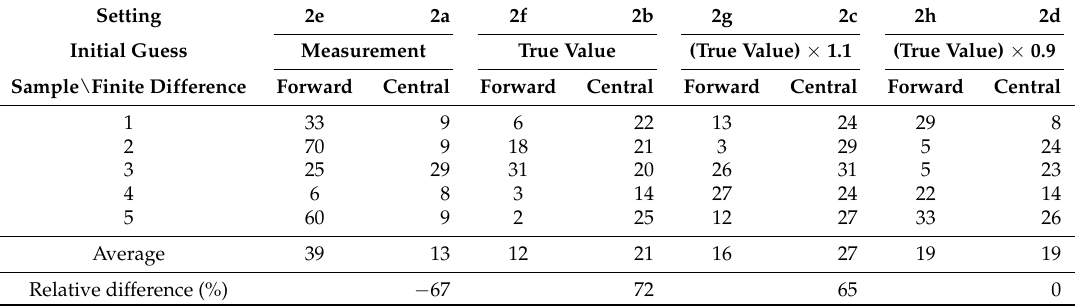
Table 8. Elapsed time (min) for solving the DR problem as a function of the initial guess and type of finite difference.